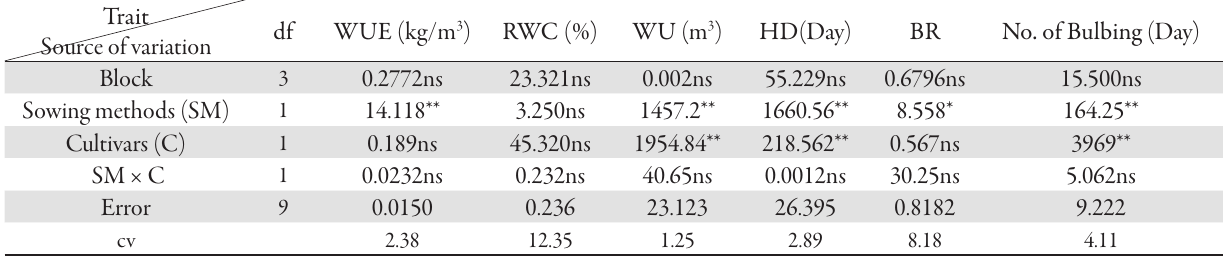
Tab. 4. Analysis of variance effect of sowing methods and cultivars on water use efficiency, relative water content, water used, harvesting date, bulbing ratio and number of day bulbing